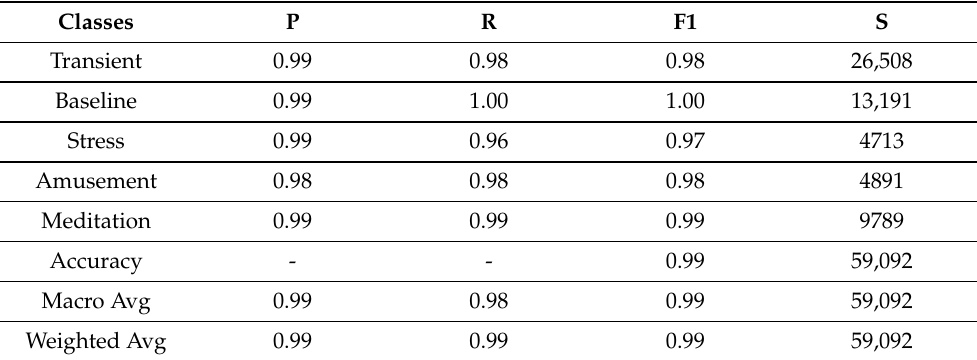
Table 2. Proposed model result of Client 1 for round 2. Key: Precision-P; Recall-R; F1-score-F1;